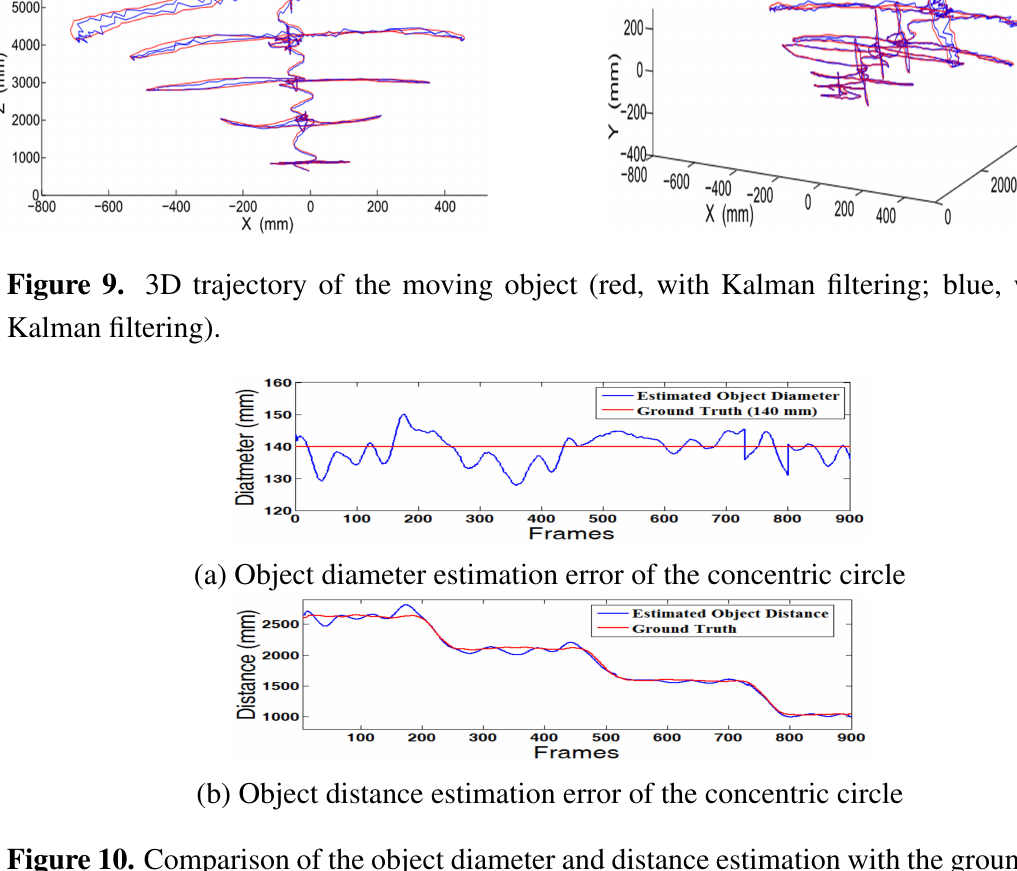
Figure 10. Comparison of the object diameter and distance estimation with the ground truth. ( a ) Object diameter estimation error of the concentric circle; ( b ) Object distance estimation error of the concentric